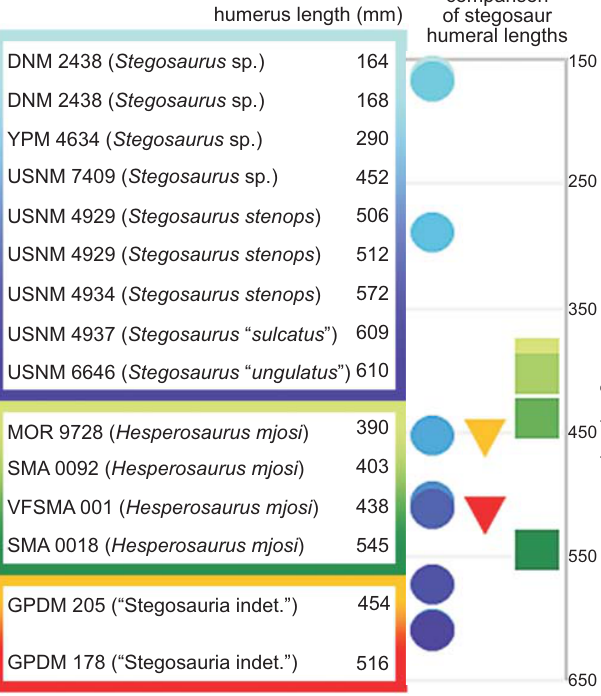
Fig. 20. Stegosaur humeral lengths (measurement from Gilmore 1914, Galton 1982a, and Maidment et al. 2018). The grading colors represent the transitions from the smallest to largest specimens. Circles, Stegosaurus ; triangles, Stegosauria indeterminate; squares, Hesperosaurus